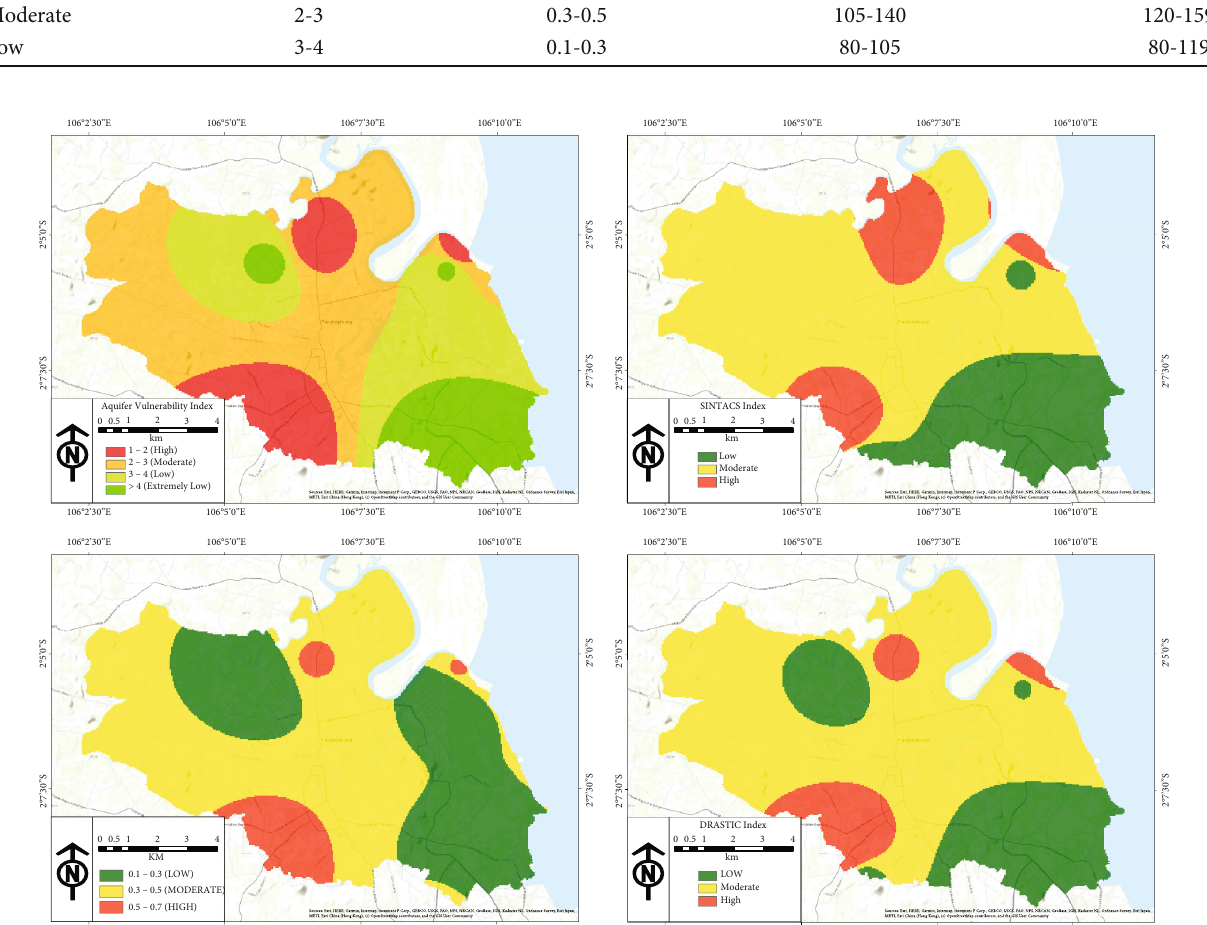
Figure 12: Groundwater vulnerability maps with DRASTIC, AVI, and GOD